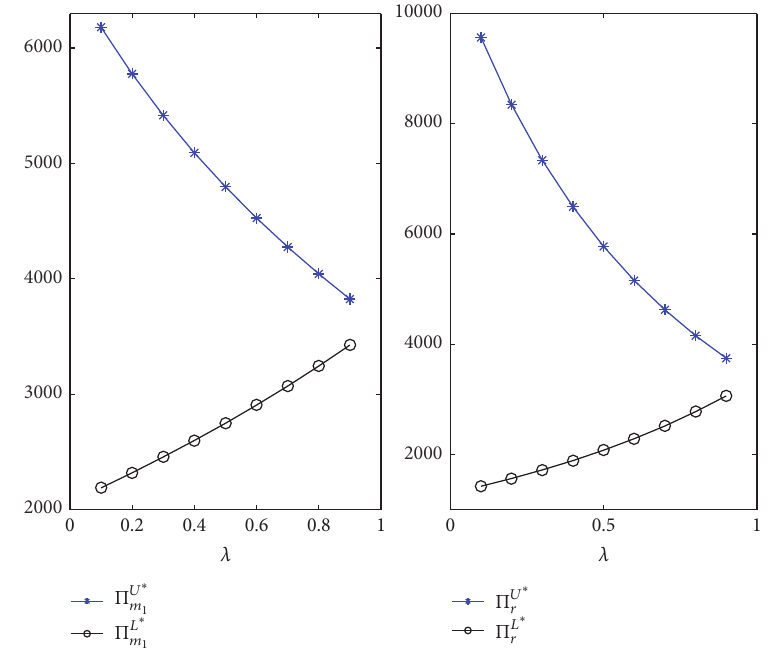
Figure 2: Changes of firms’ maximal profits with 𝜆 in MSU and MSL model.